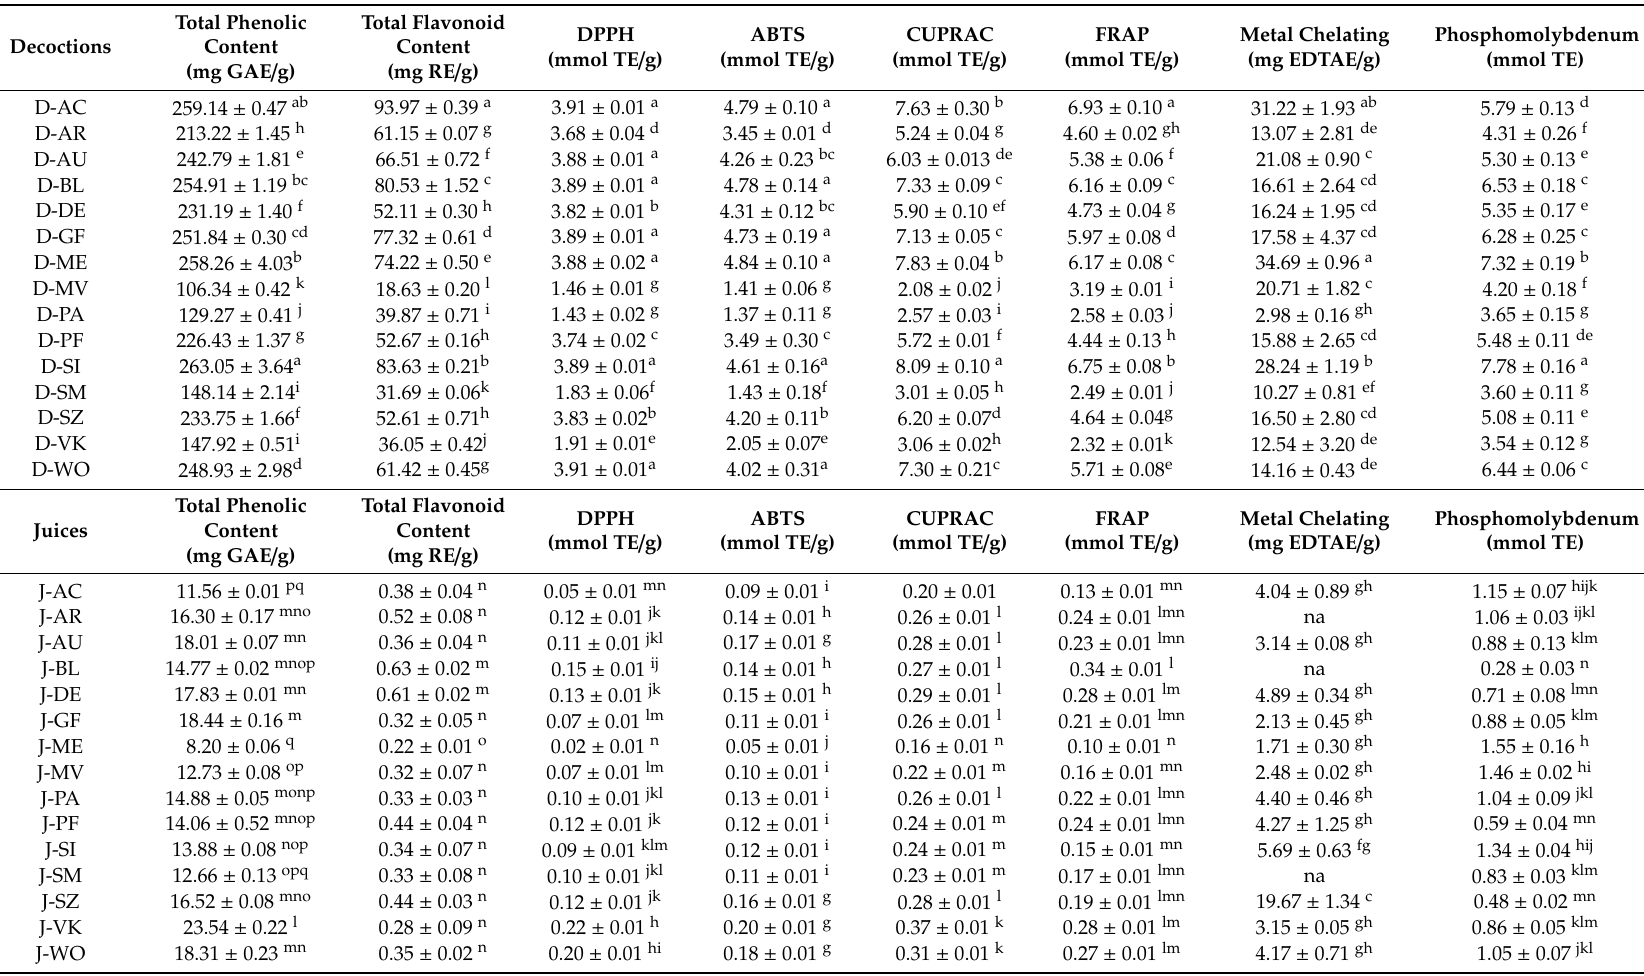
Table 6. All values are reported as mean ± SD of three independent experiments. GAE: Gallic acid equivalent; RE: Rutin equivalent; TE: Trolox equivalent; EDTAE: EDTA equivalent; na: not active. Di ff erent letters in the same column indicate significant di ff erences in the extracts ( p >